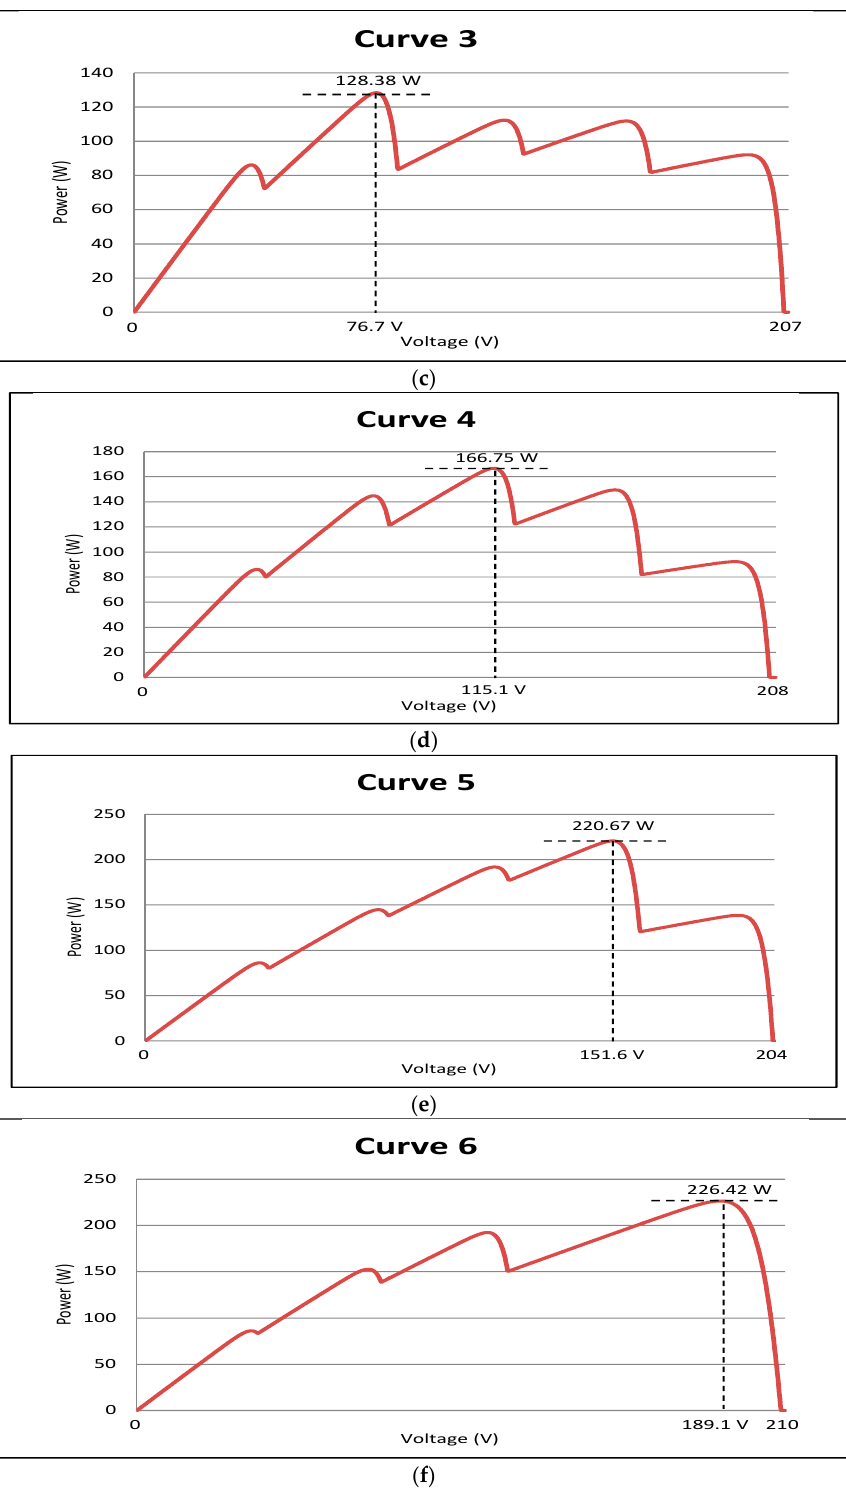
Figure 11. P-V curve characteristics: ( a ) Curve 1 with a single peak. ( b ) Curve 2 with left side peak. ( c ) Curve 3 with left-middle side peak. ( d ) Curve 4 with the middle peak. ( e ) Curve 5 with right-middle side peak. ( f ) Curve 6 with right side peak. Table 3. Algorithm parameters.